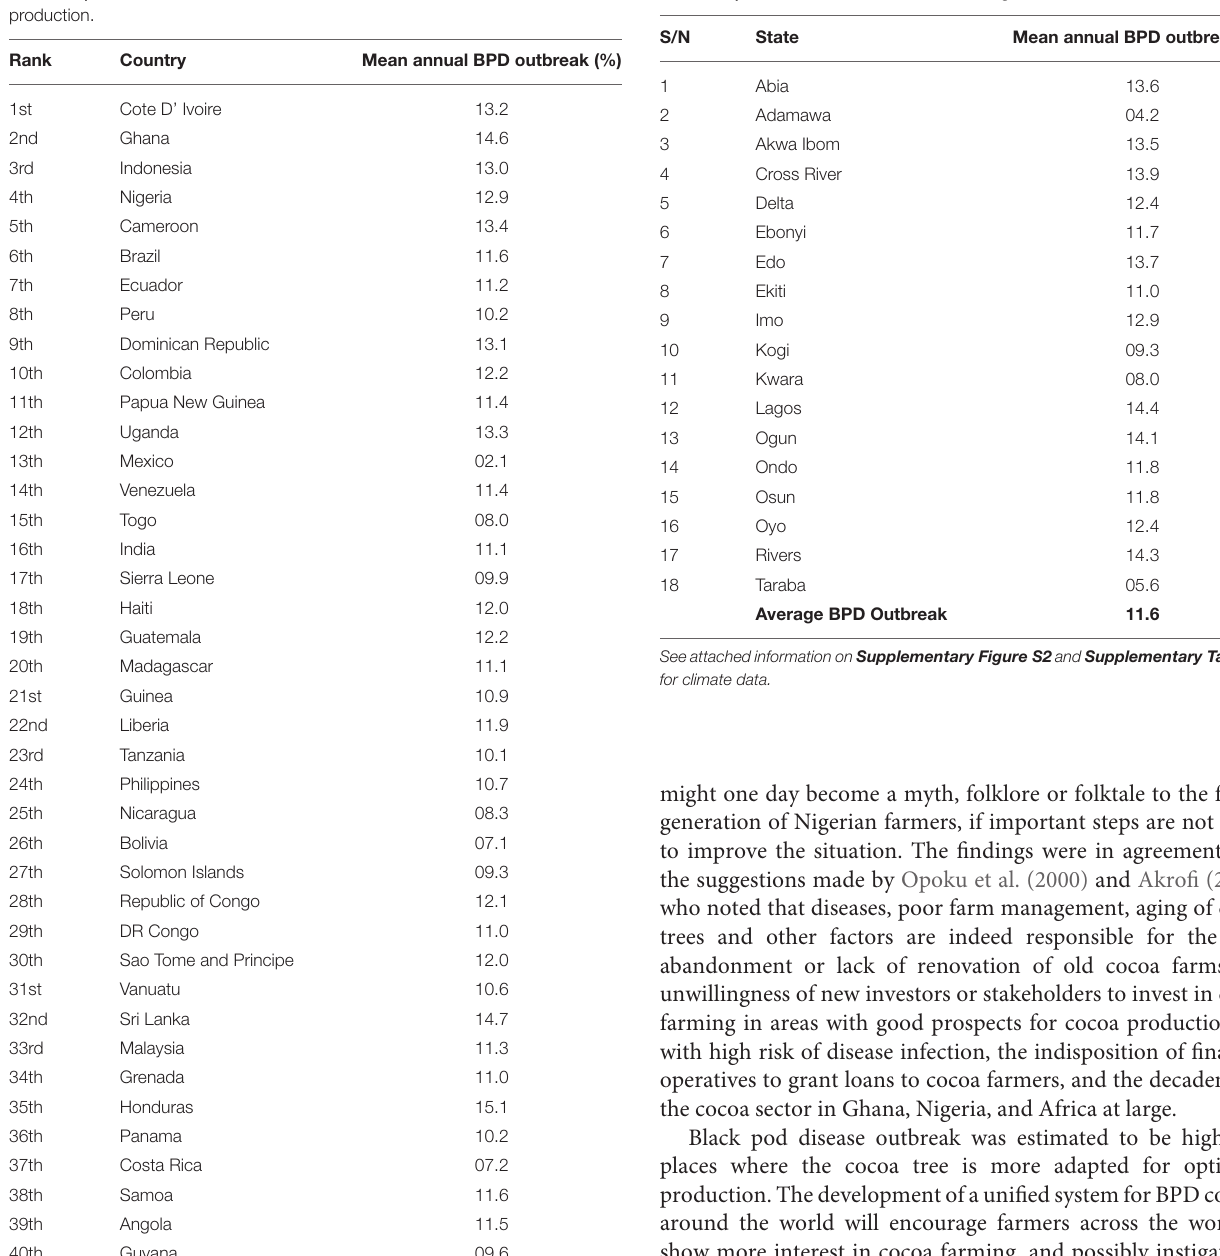
TABLE 4 | An estimate of BPD outbreak in